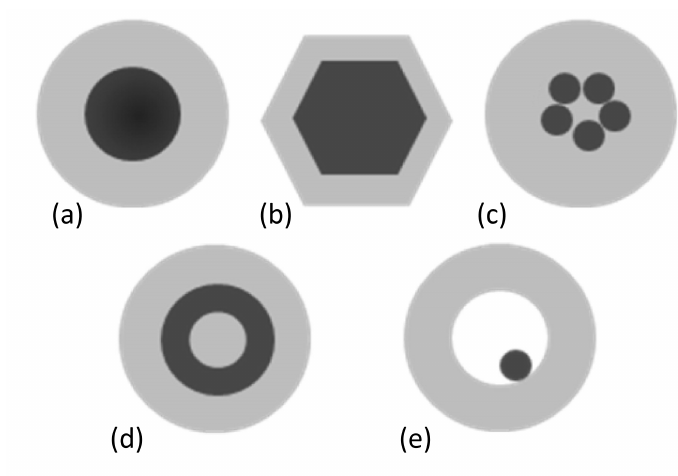
Figure 2. Schemes of the different core/shell nanoparticles: ( a ) spherical core/shell, ( b ) hexagonal core/shell, ( c ) multiple small core materials coated by a single shell material, ( d ) nanomatryushka material, and ( e ) movable core within a hollow shell material. Figure reproduced from Ref.